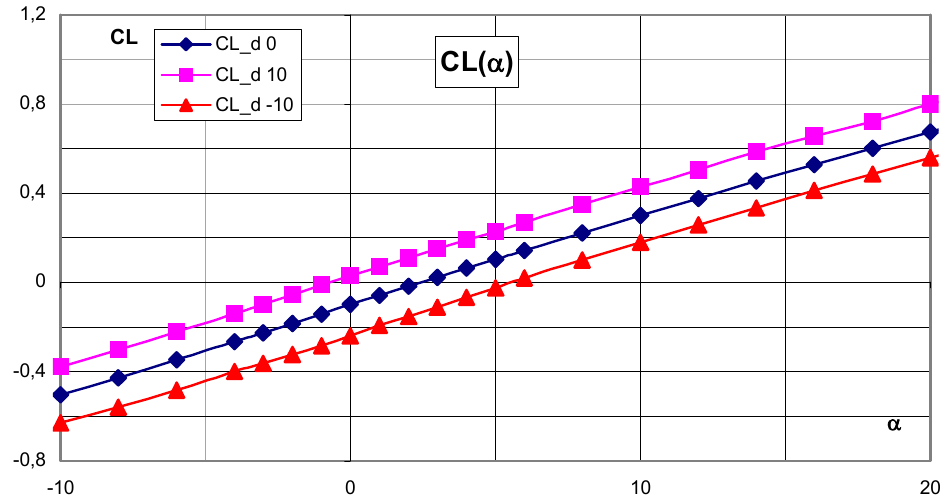
Fig 19. Lift coefficient versus angle of attack for clean conFig. uration (d=0), flap-tabs deflected down (d=10), and flap-tabs deflected up (d=-10); Ma=0.5, Re=28x10